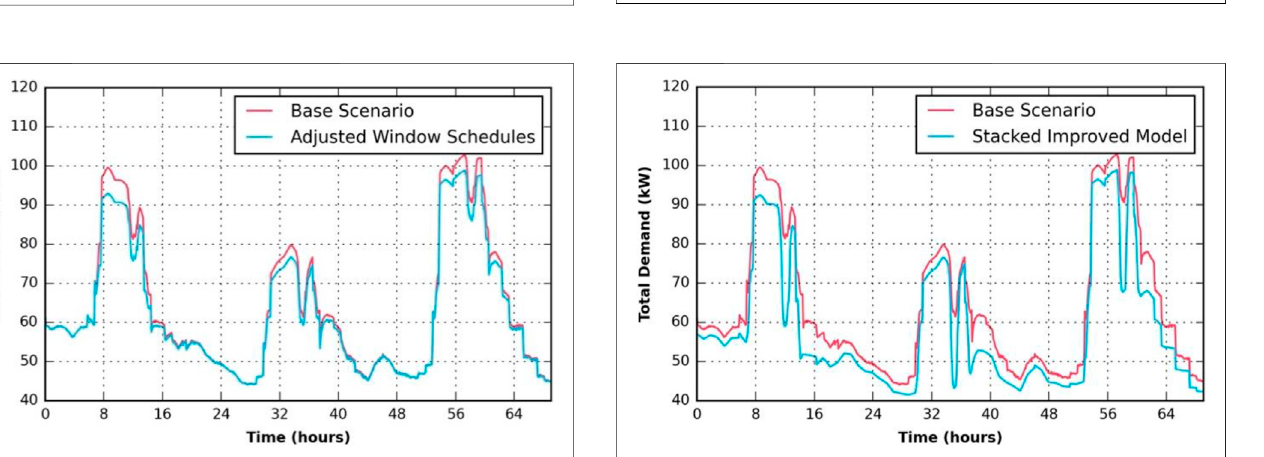
FIGURE 14 | Improving building electricity consumption by adjusting lighting system operation following of fi ce occupancy.